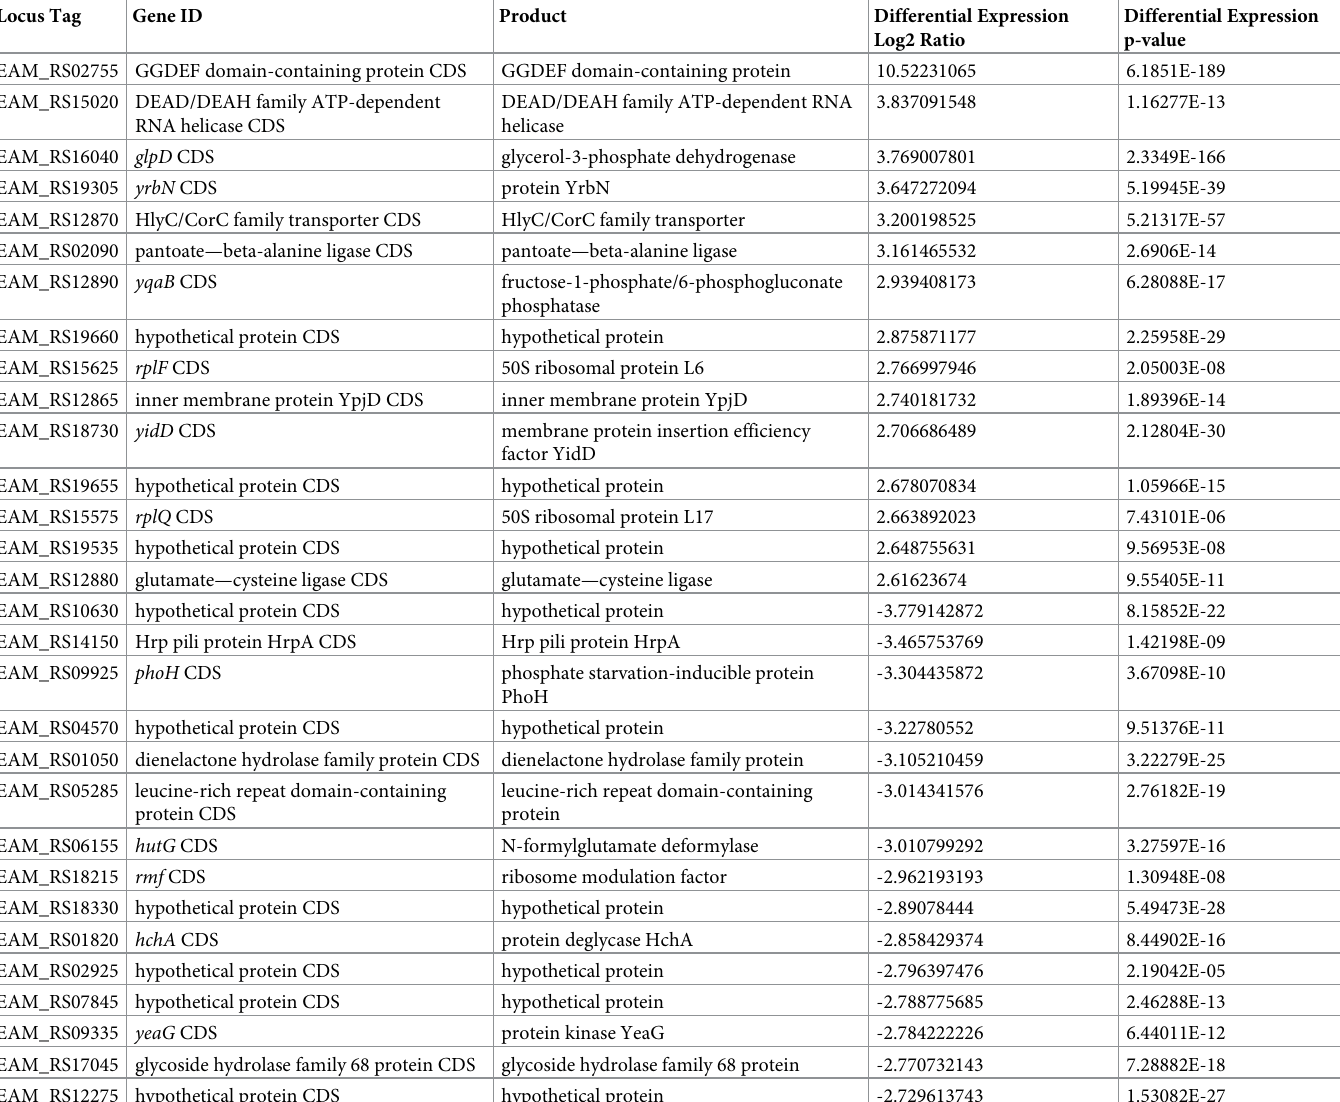
Table 4. A list of the 15 most positively and negatively regulated genes in Ea1189 Δ 8+ edcB OE relative to Ea1189 Δ